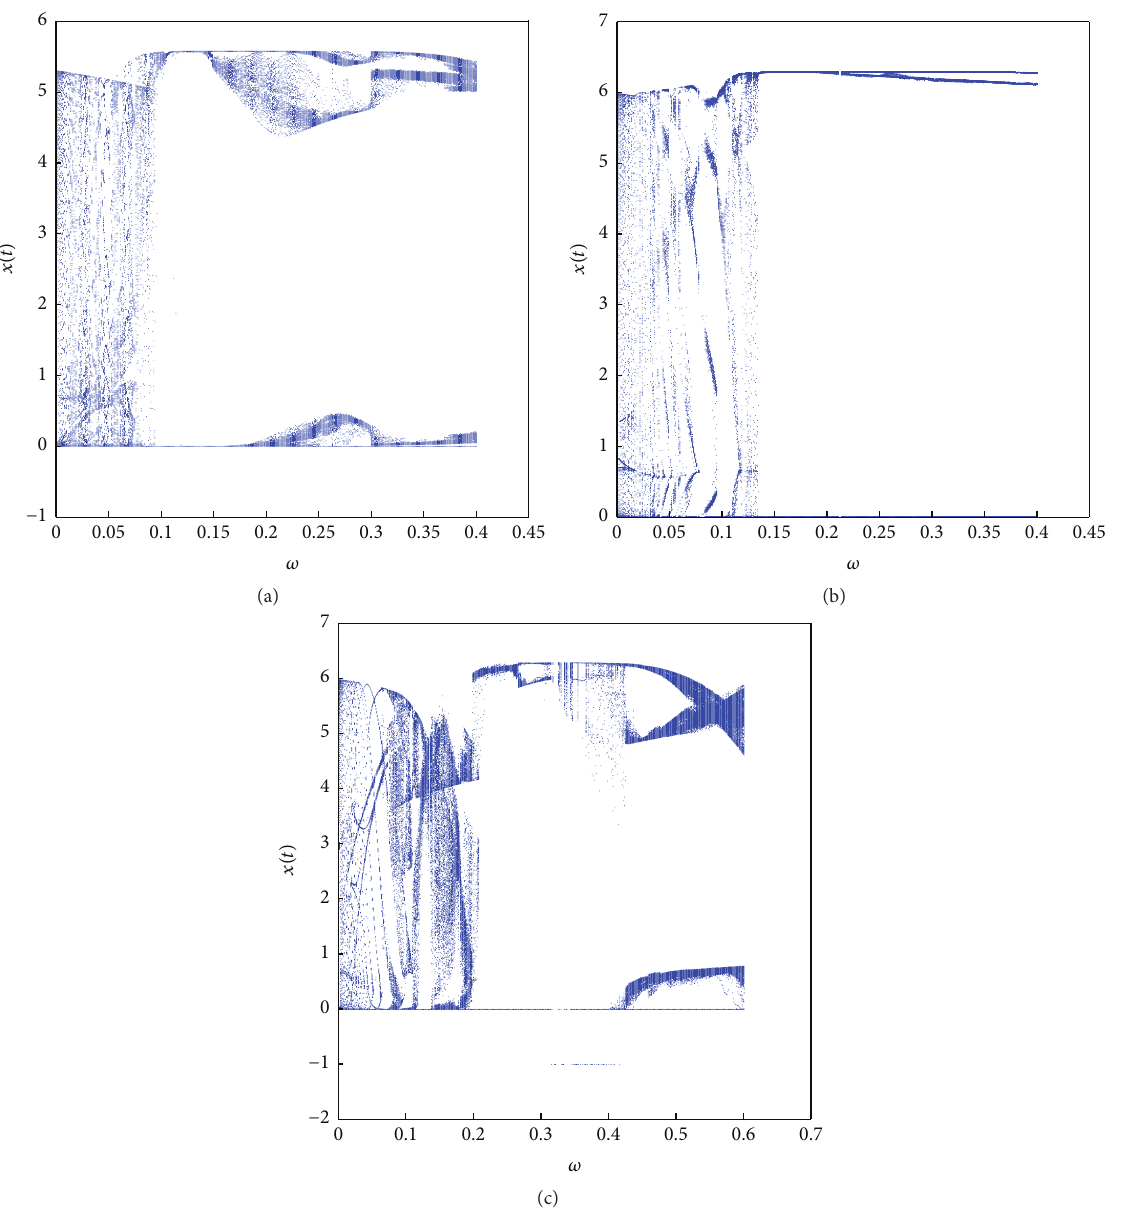
Figure 4: Bifurcation diagram of system (1) with mixed Holling type II–IV functional responses with respect to seasonal parameter 𝜔 for (a) 𝜓 = 0 , 𝜙 = 𝜋/2 , (b) 𝜓 = 𝜋/2 , 𝜙 = 𝜋/2 , and (c) 𝜓 = 𝜋 , 𝜙 = 𝜋/2 with data set (45).